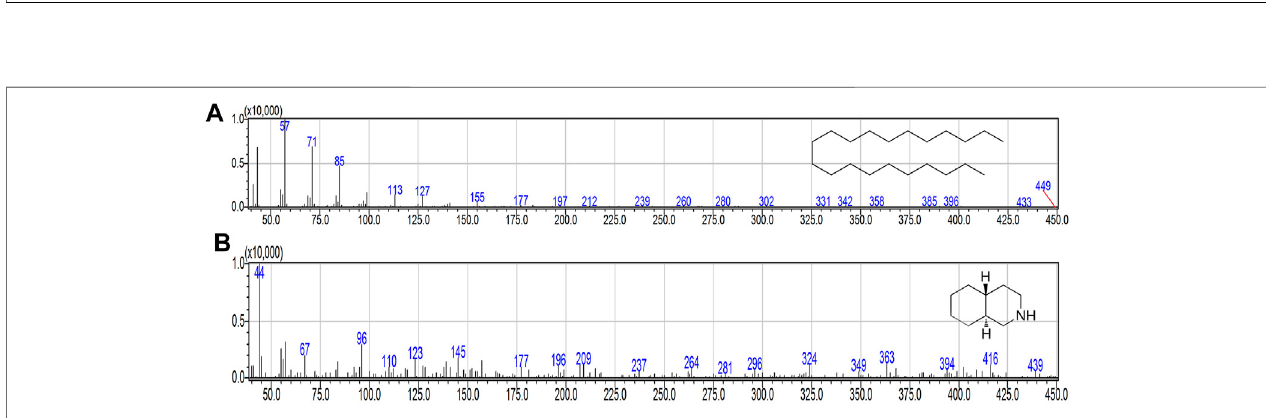
FIGURE 6 | MS spectra of puri fi ed compounds. (A) henicosane. (B) decahydroisoquinoline.